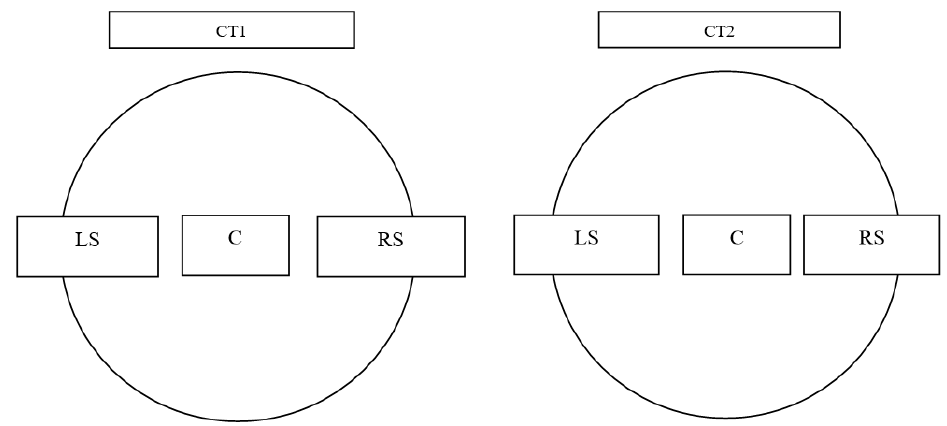
Figure 2. Block location diagram.